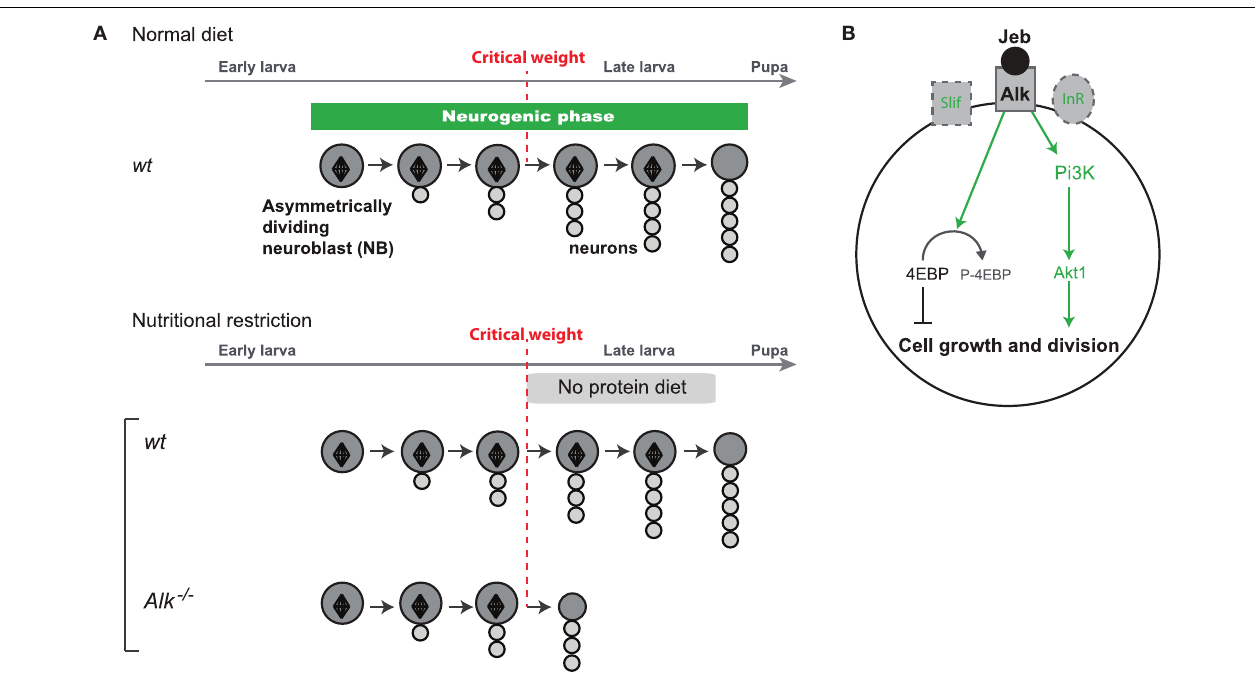
FIGURE 3 | Protection of neuroblast growth and proliferation by ALK. (A) Alk tyrosine kinase protects growth and proliferation of neuroblasts in the absence of dietary nutrients after the critical weight. (B) Under nutrient restriction, the InR and amino-acid sensing pathways are not activated leading to growth arrest in most tissues. In neuroblasts, Alk is activated by its